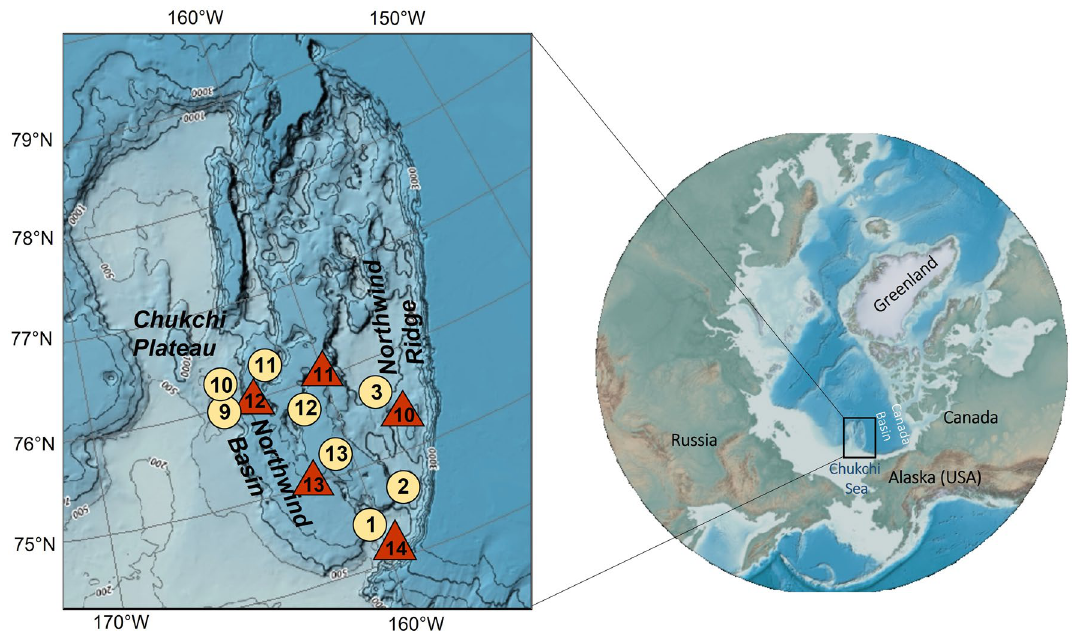
Figure 5. Study area and stations sampled in the Arctic Chukchi Borderland. Stations sampled in 2005 and 2016 are indicated by yellow circles and red triangles, respectively. Numbers in bold print are station numbers; small numbers along isobaths indicate water depth. The map was created using ESRI ArcGIS 10.5 software (http:// www. esri. com/ softw are/ arcgis/ arcgis- for- deskt